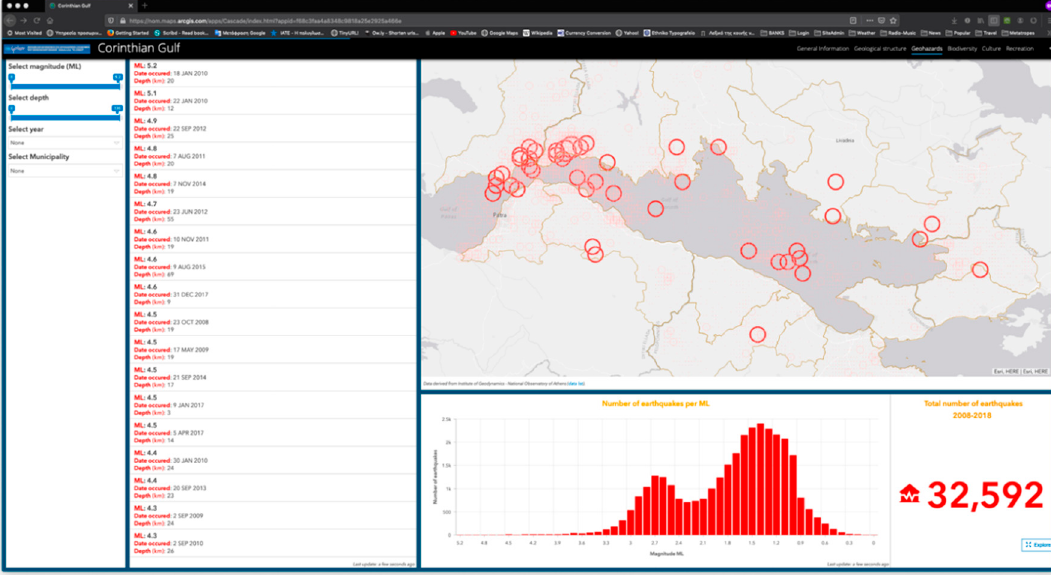
Figure 2. Earthquakes around the Corinthian Gulf which occurred in the period 2008–2018 (https://arcg.is/1n4yHv). This dashboard has been created to highlight the high seismicity of the Corinthian Gulf as part of its geodiversity (https://tinyurl.com/wrewbga).